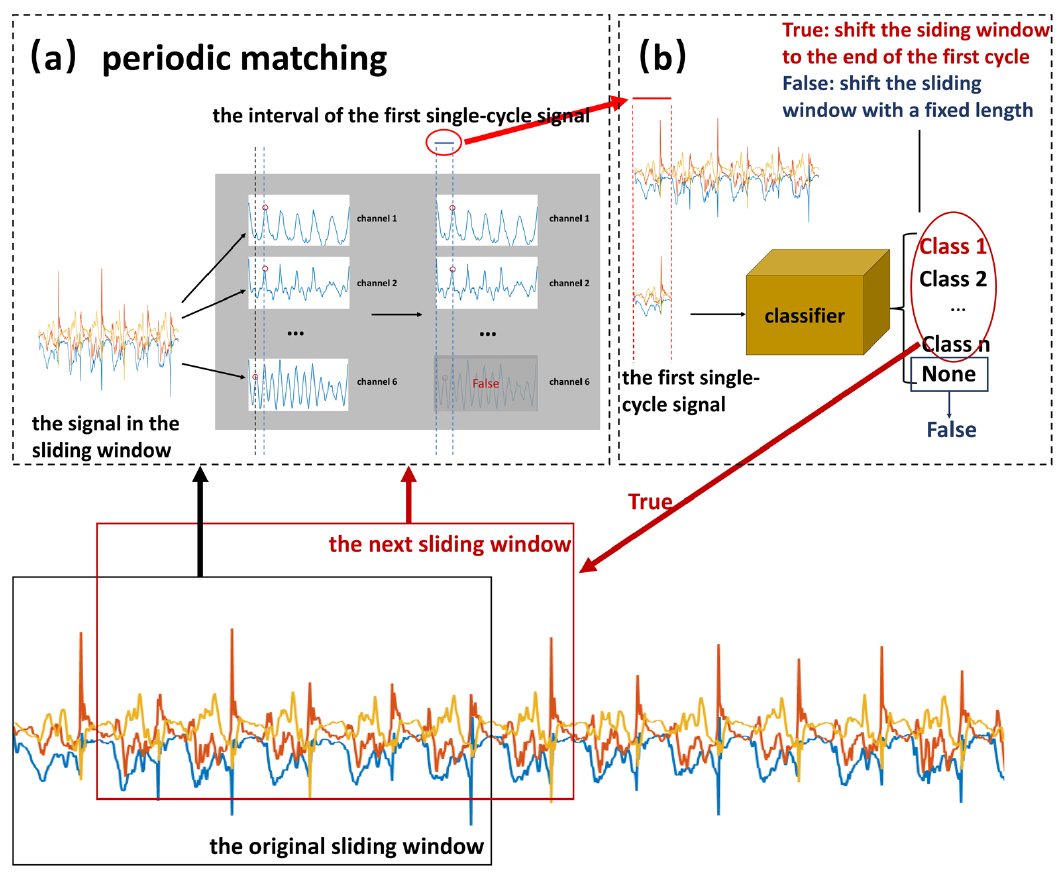
Figure 5. The flowchart of weak periodicity and complex motion states (WP_CMS) activity detection and recognition. ( a ) The pipeline of periodic matching method. ( b ) The pipeline of recognition